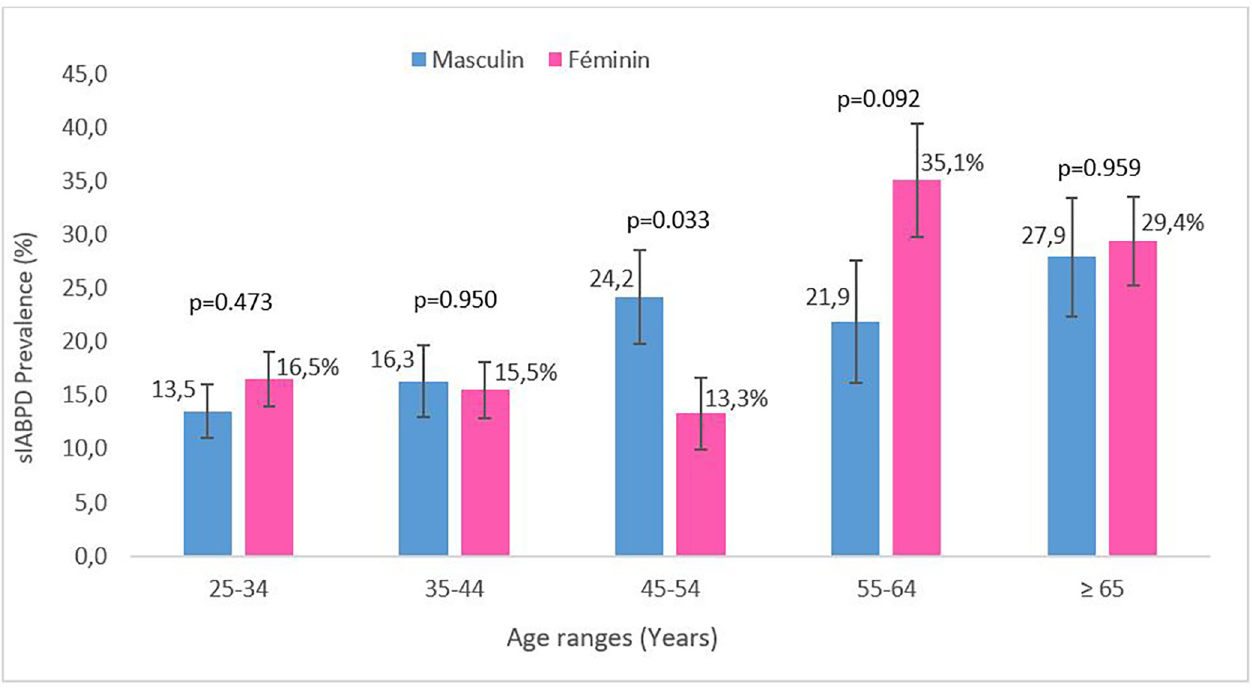
Fig 3. Gender prevalence of systolic inter-arm blood pressure difference (sIABPD) � 10 mmHg by age groups, TAHES study, Benin 2020.